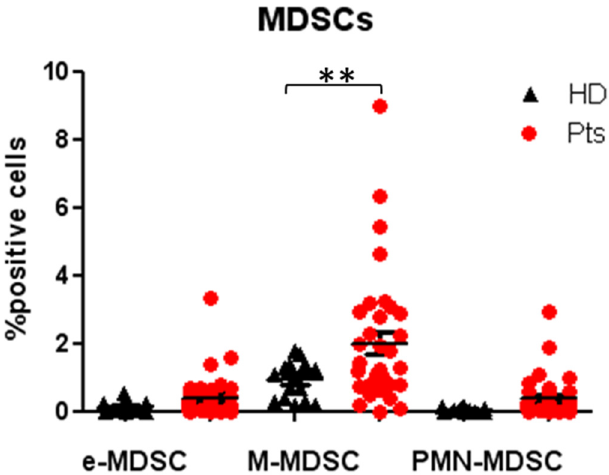
Figure 7. Evaluation of MDSCs subsets in patients and HDs at baseline: Percentage of circulating early MDSC (e-MDSC), myeloid MDSC (M-MDSC) and polymorphonuclear MDSC (PMN-MDSC) in patients and healthy donors, expressed as percentage of cell positives for the relative markers reported in Figure 6. ** p < 0.005. Pts, patients; HDs, Healthy donors; MDSC, myeloid-derived suppressor cells.